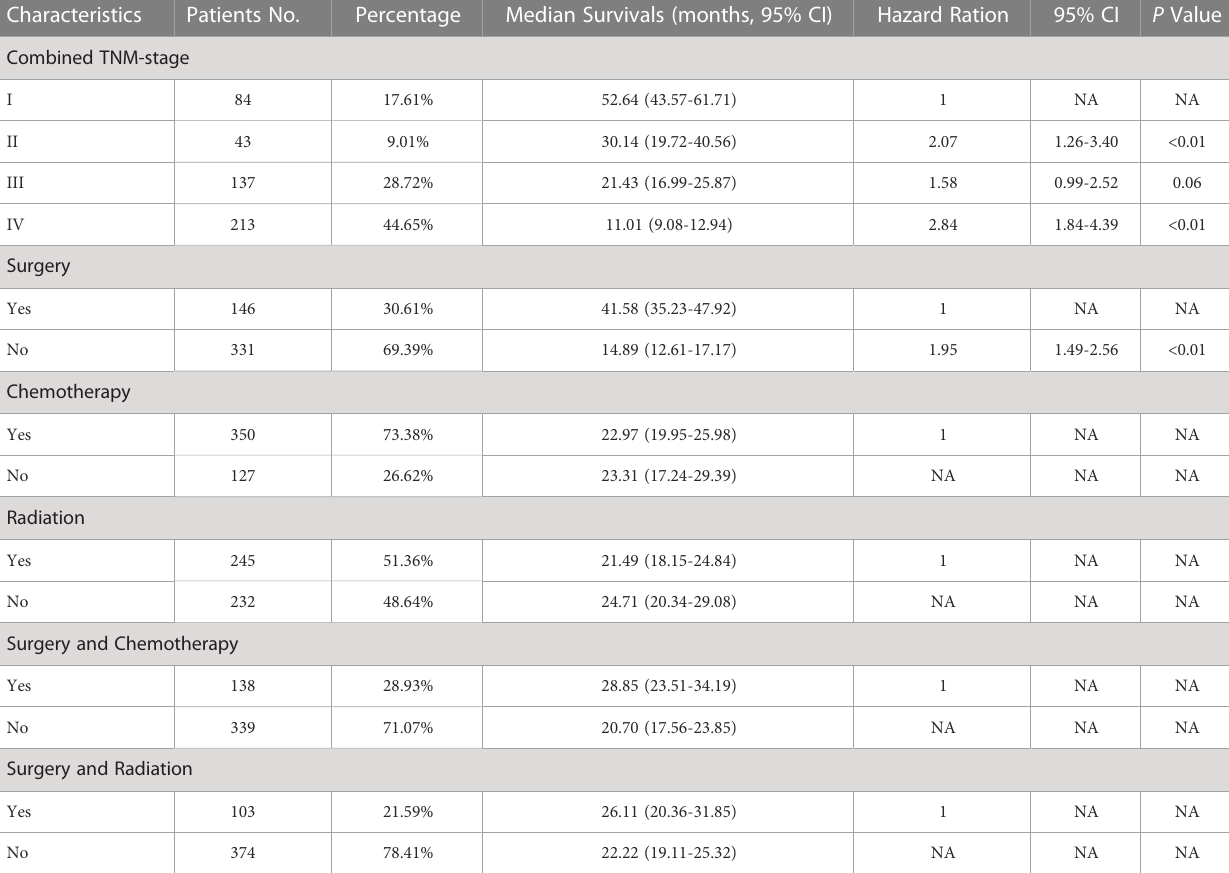
TABLE 3 Combined TNM stage and treatment characteristics, median overall survivals, and multivariable cox regression for patients with C-SCLC. Characteristics Patients